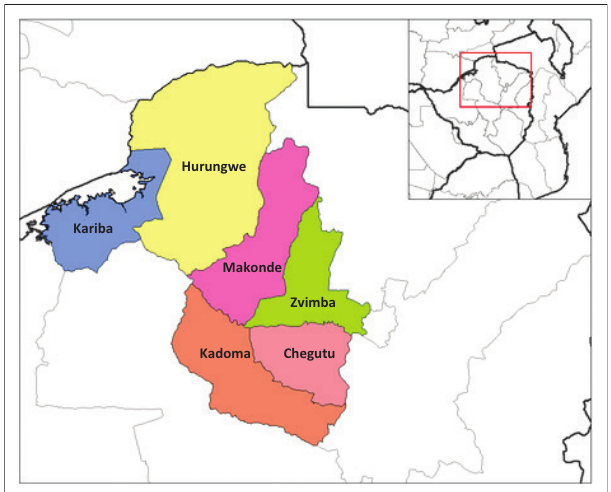
FIGURE 1: Map showing Zvimba